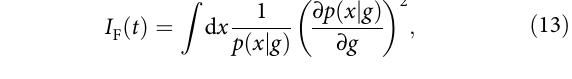
Fig. 4 Fisher information for measurements of gravitational acceleration g . Plots of the quantum Fisher information (QFI) and classical Fisher information (CFI) for measurements of g . a shows the QFI H Q ( t ) for 1, 4 and 9 photons j α j 2 with rescaled couplings (cid:2) k ¼ (cid:2) g ¼ 1. b shows the dimensionless CFI (cid:2) I and without photon dissipation rate (cid:2) κ ¼ κ = ω m for a momentum measurement ( λ = 1/2) and (cid:2) k ¼ (cid:2) g ¼ 1. c shows how the peak of the CFI for a momentum measurement narrows with increasing (cid:2) k and with constant (cid:2) g ¼ 1. d shows the I F ( t ) for a momentum measurement of photons that leak from the cavity with environmental coupling (cid:2) γ ¼ 0 : 1 and (cid:2) k ¼ (cid:2) g ¼ 1. All plots use parameter β =